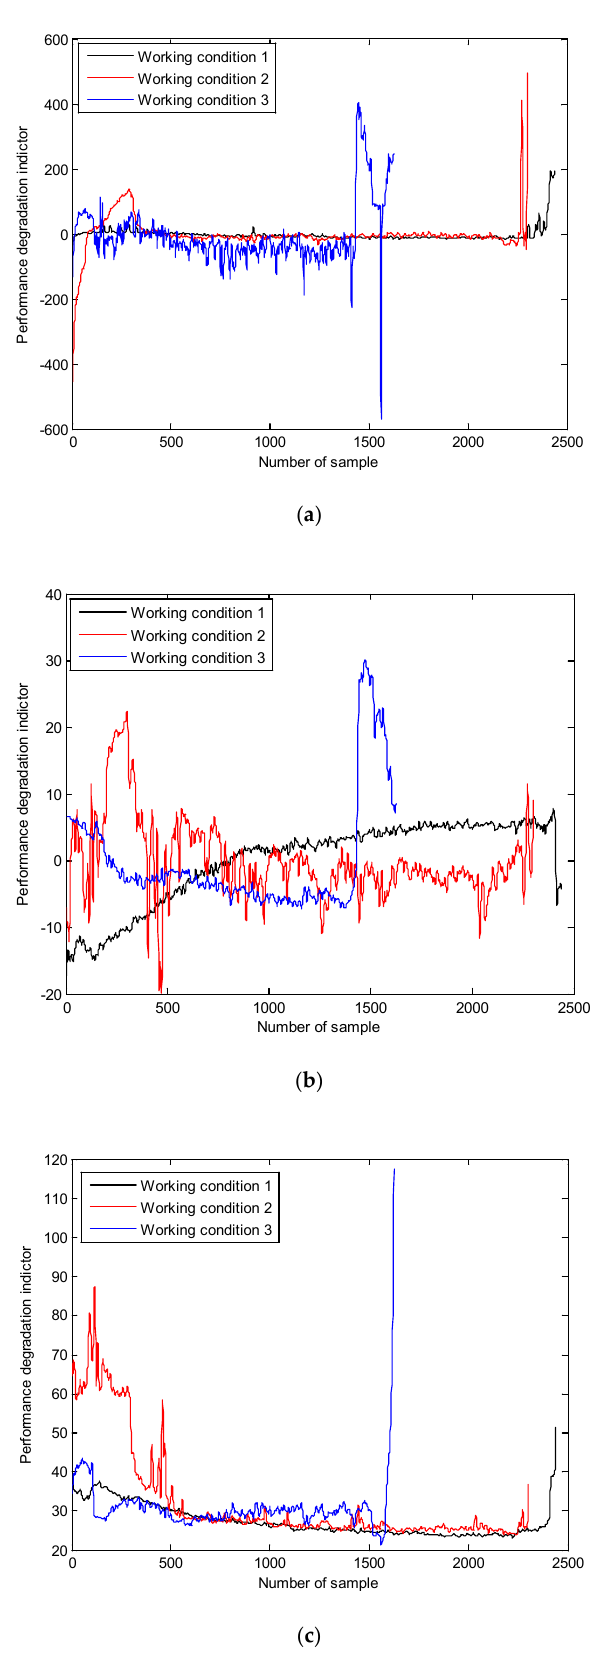
Figure 6. Different performance degradation index. ( a ) Time–frequency domain; ( b ) wavelet packet space; ( c ) EEMD